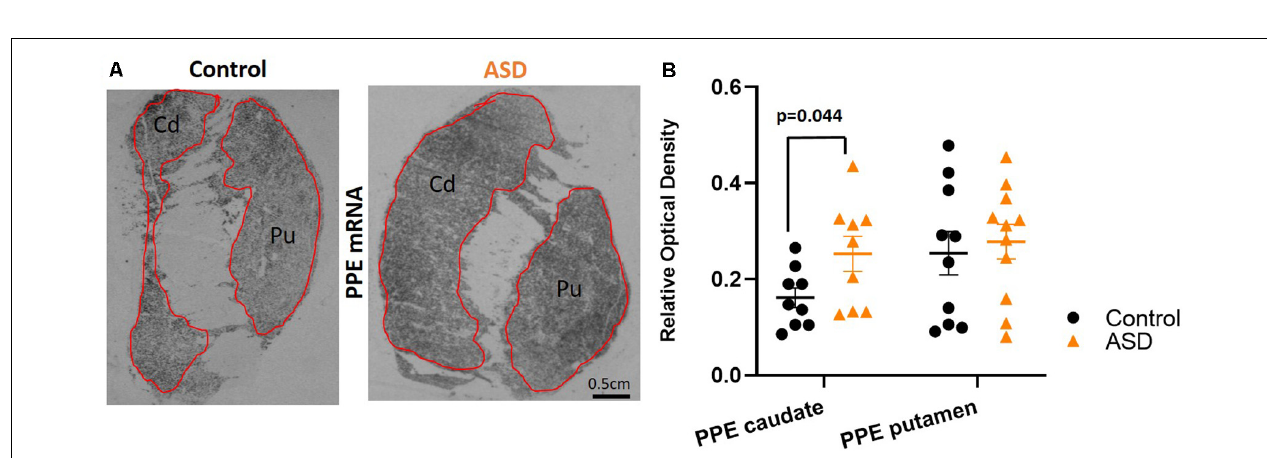
FIGURE 4 | (A) Preproenkephalin mRNA labeling with radioisotopic in situ hybridization histochemistry. (B) Preproenkephalin is increased in the caudate, but not in the putamen of ASD cases. n = 10 control putamen, nine control caudate; 11 ASD putamen, nine ASD caudate.